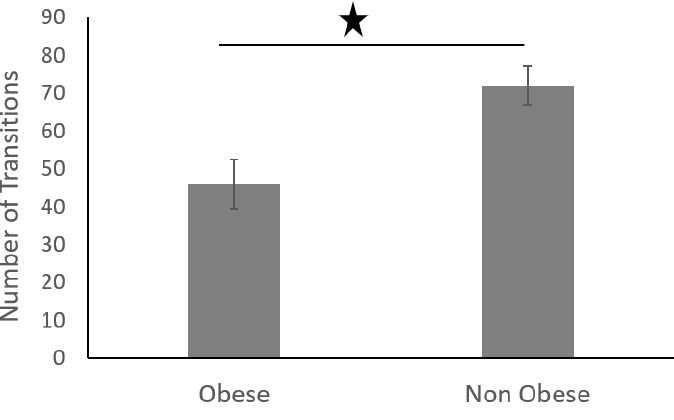
Figure 16. Average number of transitions in each phase of sleep.